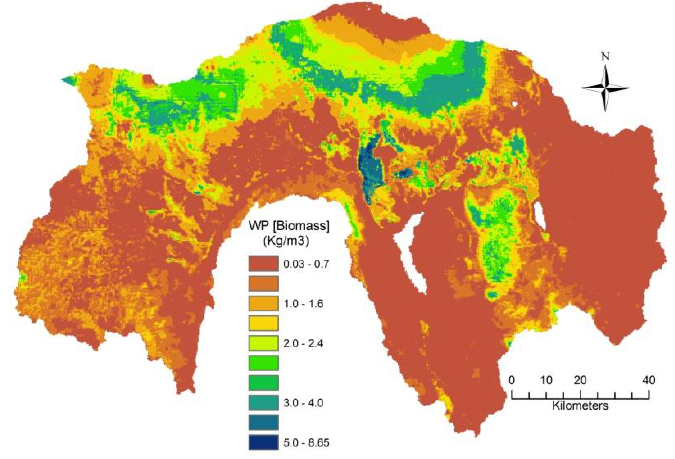
Figure 5. Water Productivity (Biomass) for the period of 2008–2010, in the Upper Pangani River Basin.